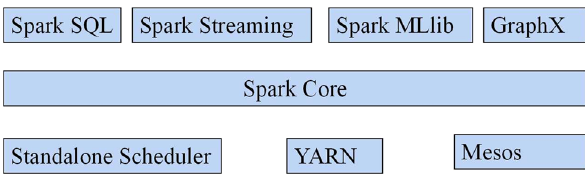
Figure 1: The Spark system component